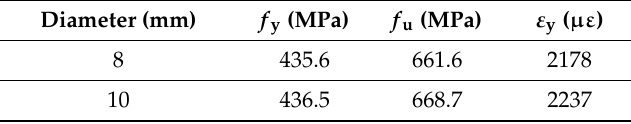
Table 2. Mechanical properties of steel rebar.